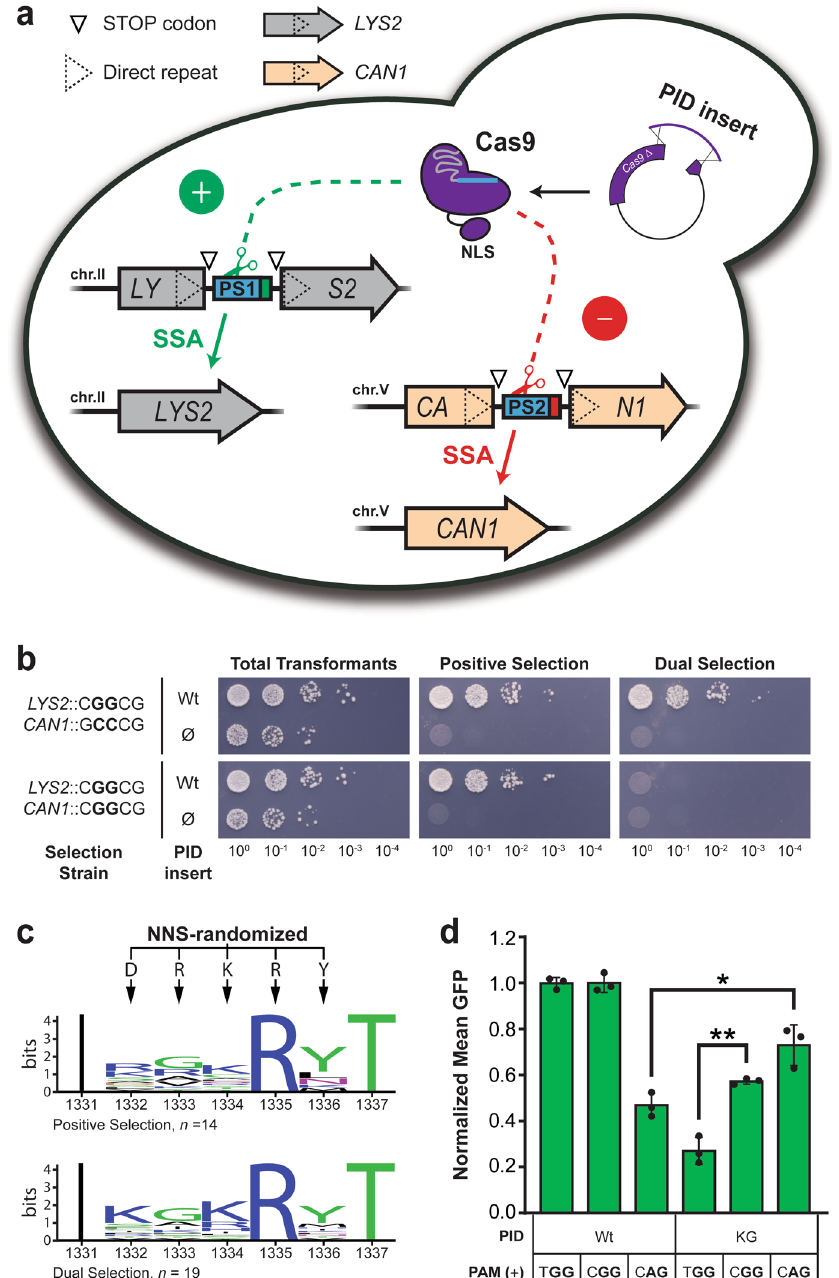
Fig. 2 Cleavage-dependent selections in S. cerevisiae converge on a doubly substituted PID variant with altered PAM preference. a Schematic summary of the single-strand annealing (SSA) reporters employed for dual selection in yeast. The endogenous LYS2 and CAN1 marker loci are disrupted with identical protospacer insertions (PS1 or PS2, with PAMs in green or red) fl anked by stop codons and ~100 bp direct repeat sequences which are not naturally duplicated in their respective native loci. Transformation-associated assembly of the Cas9 backbone with a complementing PID fragment allows for cleavage-dependent reconstitution of one or both markers through the SSA pathway. A single SV40 nuclear localization signal (NLS) is fused to the C- terminus of Cas9. b Validation of the yeast system using two selection strains con fi gured with CGG or GCC PAMs at their LYS2 and CAN1 loci as indicated. Strains were transformed with backbone DNA and either a Wt PID insert or no PID (Ø), and plated in parallel as 10-fold serial dilutions on positive- and dual-selection media, as well as control media to enumerate total transformants. c WebLogo 37 summaries of NNS-randomized residues identi fi ed in non- Wt isolates from the positive-selection (top) or dual-selection (bottom) screening experiments. The number of isolates used to generate each plot is denoted below. Recoded Wt isolates were not detected in either of these experiments. d GFP activation assays comparing the KG variant with Wt, normalized as in Fig. 1b. PAMs present at the upstream protospacer in single-target reporter plasmids are indicated below. Error bars, mean ± s.d. ( n = 3, biological replicates). * p = 0.0180; ** p = 0.0099. Source data are available in the Source Data fi le.